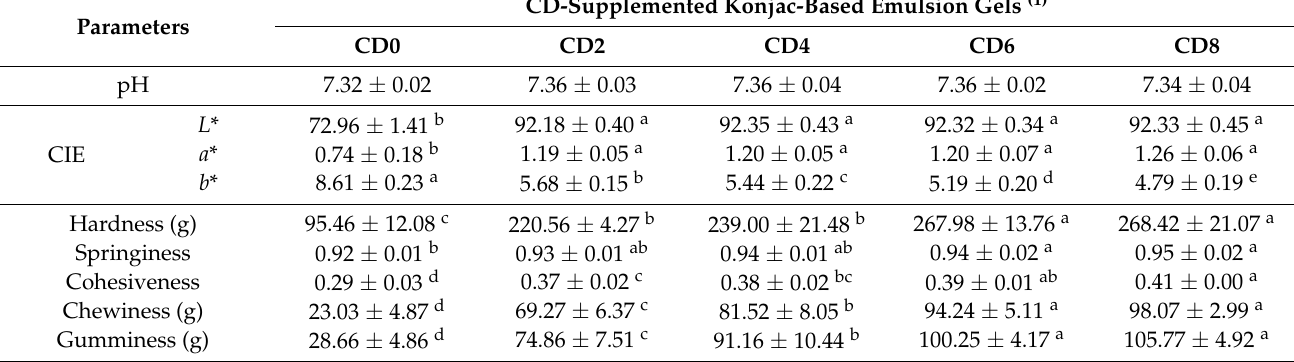
Table 1. pH, color, and texture parameters of emulsion